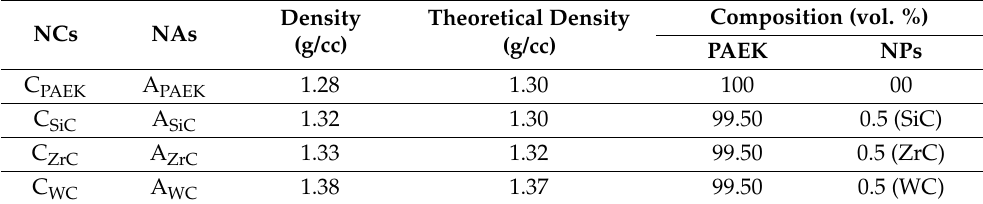
Table 2. Designations and physical properties of the developed NCs and